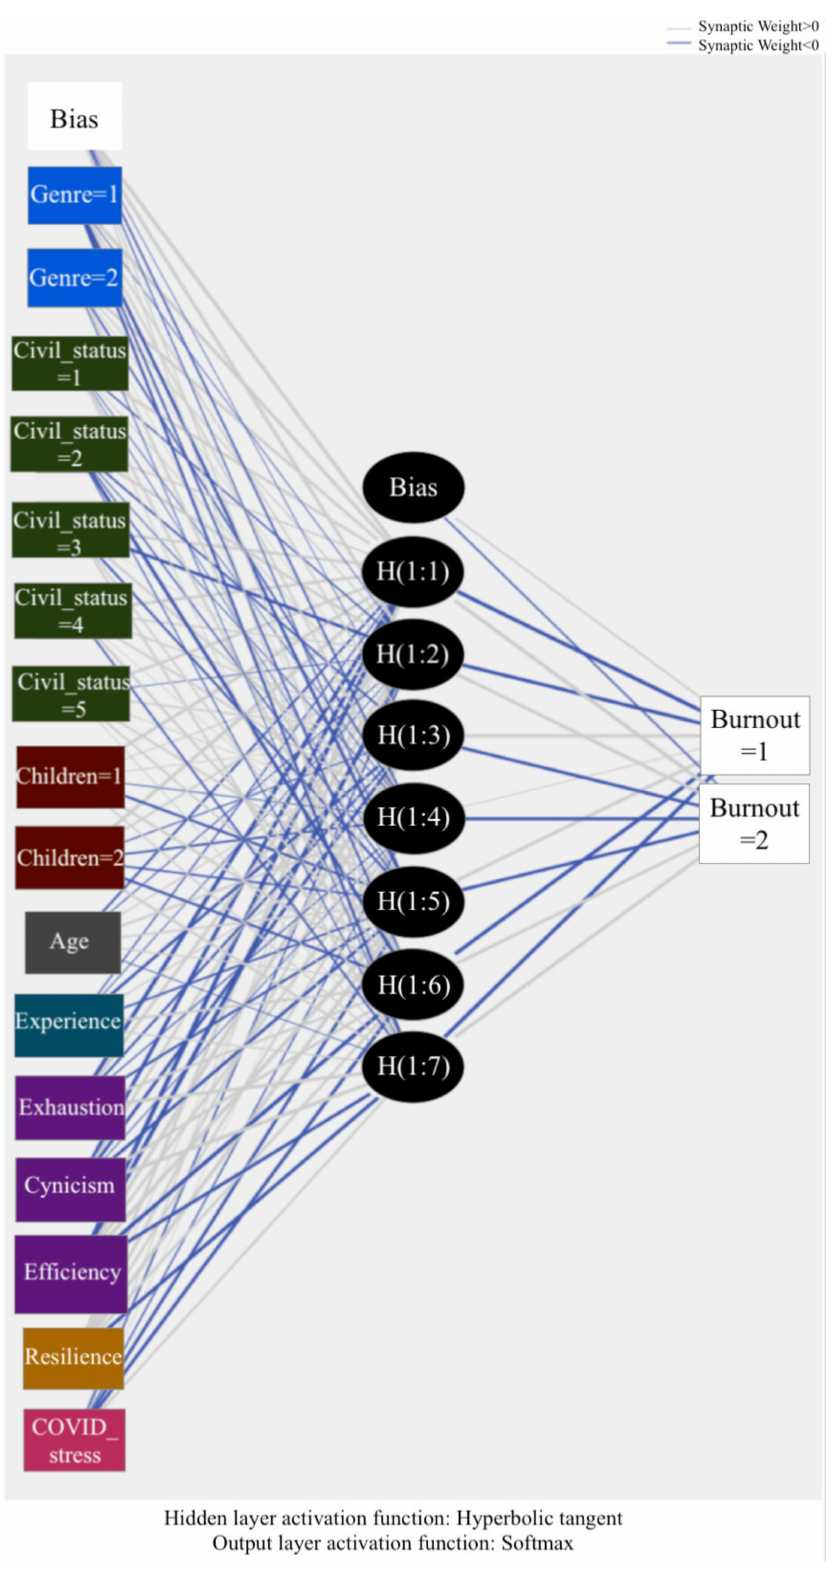
Figure 1. Artificial neural network with predictive capacity for the dependent variable burnout syndrome. Note. Genre = 1: Female; Genre = 2: Male; Civil_status = 1: Single; Civil_status = 2: With partner; Civil_status = 3: Married; Civil_status = 4: Divorced; Civil_status = 5: Widowed; Children = 1: Yes; Children = 2: No; Burnout = 0: Absence of burnout; Burnout = 1: Presence of